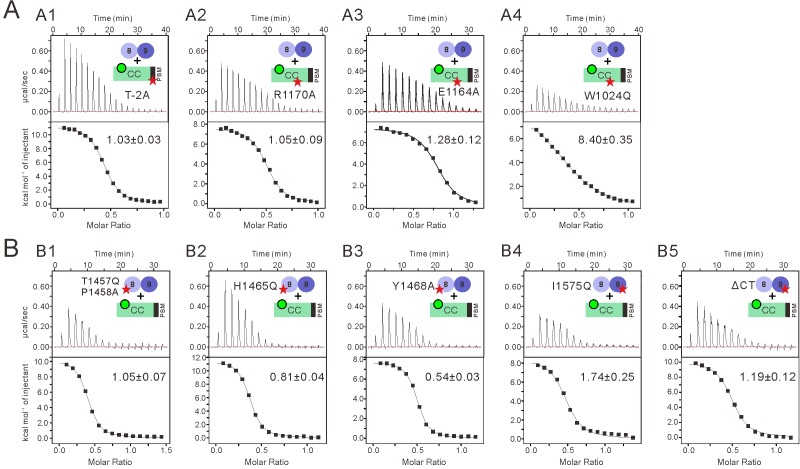
Impact of the mutations on the binding affinity between INADL PDZ89 and the PLCβ4 CC-PBM.(A) ITC-based measurements comparing the binding affinities between the WT INADL PDZ89 and various forms of PLCβ4 CC8KA-PBM. (A1) T-2 was substituted with Ala. (A2) R1170 was substituted with Ala. (A3) E1164 substituted with Ala. (A4) W1024 was substituted with Gln. (B) ITC-based measurements comparing the binding affinities between variant mutants of INADL PDZ89 and the PLCβ4 CC8KA-PBM. (B1) T1457Q and P1458A-PDZ89. (B2) H1465Q-PDZ89. (B3) Y1468A-PDZ89. (B4) I1575Q-PDZ89. (B5) Truncation of the C-terminal 10-residue extension following PDZ9 in the PDZ89 tandem.